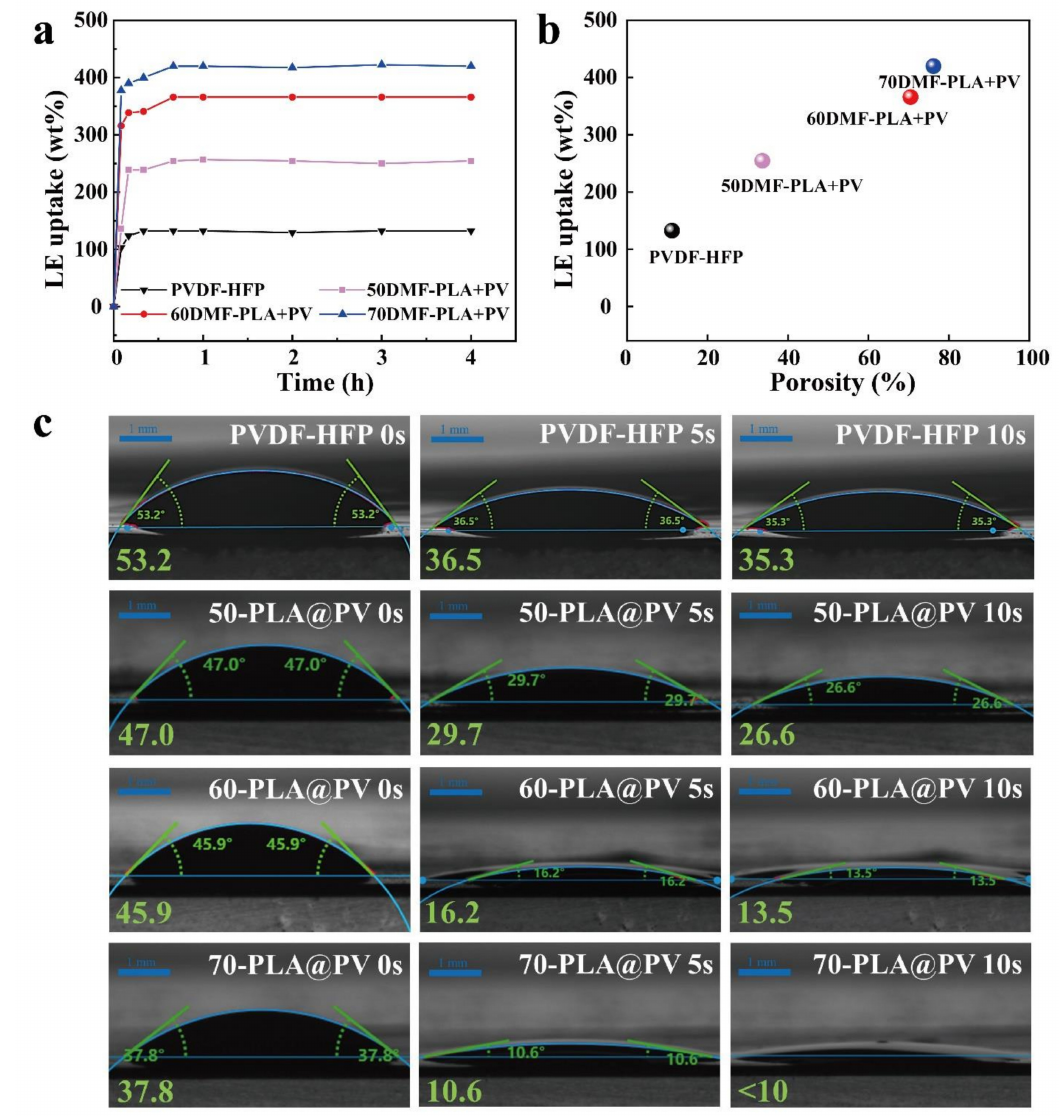
Figure 3. Properties of the membranes: ( a ) Liquid electrolyte uptake of five polymer membranes. ( b ) Liquid electrolyte uptake of membranes with different porosities. ( c ) Images of LE contact angles on PVDF-HFP, and 50-PLA@PV, 60-PLA@PV, and 70-PLA@PV at different